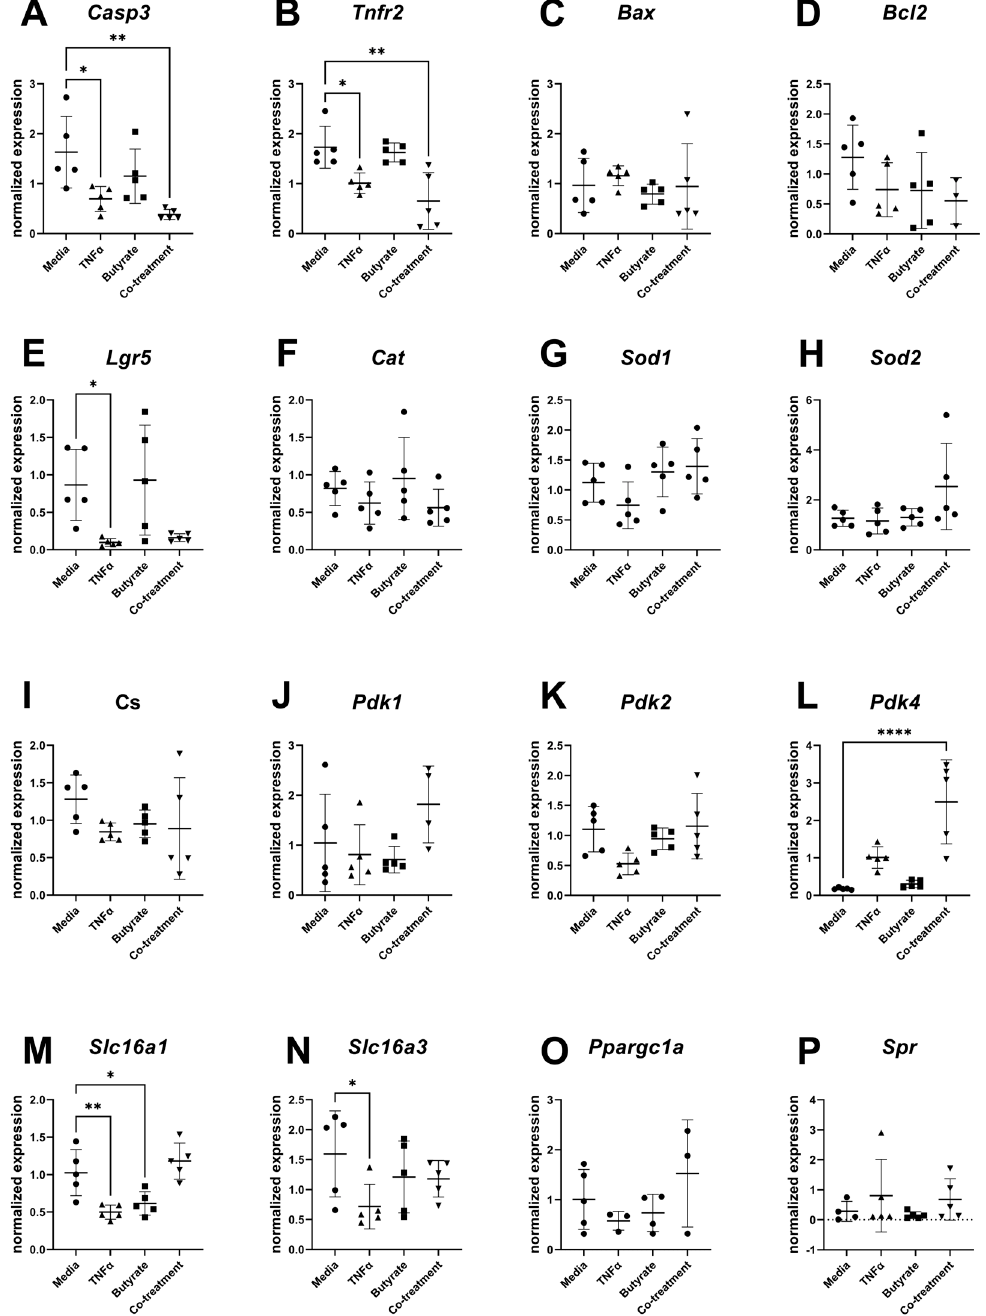
Figure 10. Relative gene expression for primary rat colon epithelial cells after 24 h exposure to butyrate and TNF α : ( A ) Casp3, ( B ) Tnfr2, ( C ) Bax, ( D ) Bcl2, ( E ) Lgr5, ( F ) Cat, ( G ) Sod1, ( H ) Sod2, ( I ) Cs, ( J ) Pdk1, ( K ) Pdk2, ( L ) Pdk4, ( M ) Slc16a1, ( N ) Slc16a3, ( O ) Ppargc1a, and ( P ) Spr. Data are presented as mean ± standard deviation. Asterisks indicate degree of significance from medium control (One-way ANOVA followed by a Dunnett’s multiple comparison test, n = 5; significance determined at * = p < 0.05, ** = p < 0.01, **** = p < 0.0001).